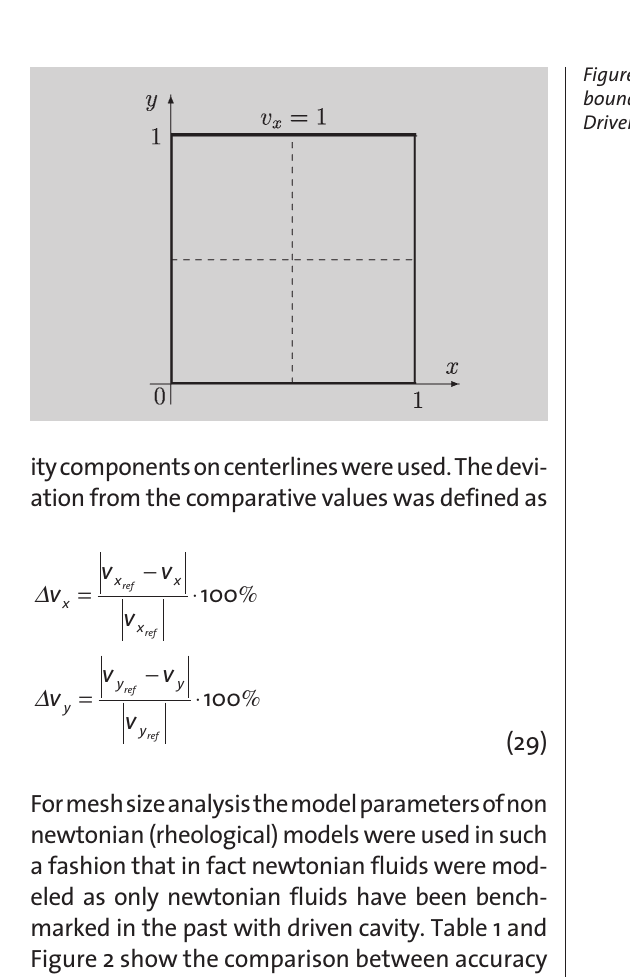
Table 1: Power Law: m = 0.0025, n = 1. Figure 2: Deviation of the lowest values of horizontal and vertical velocity compo- nents for varioius mesh